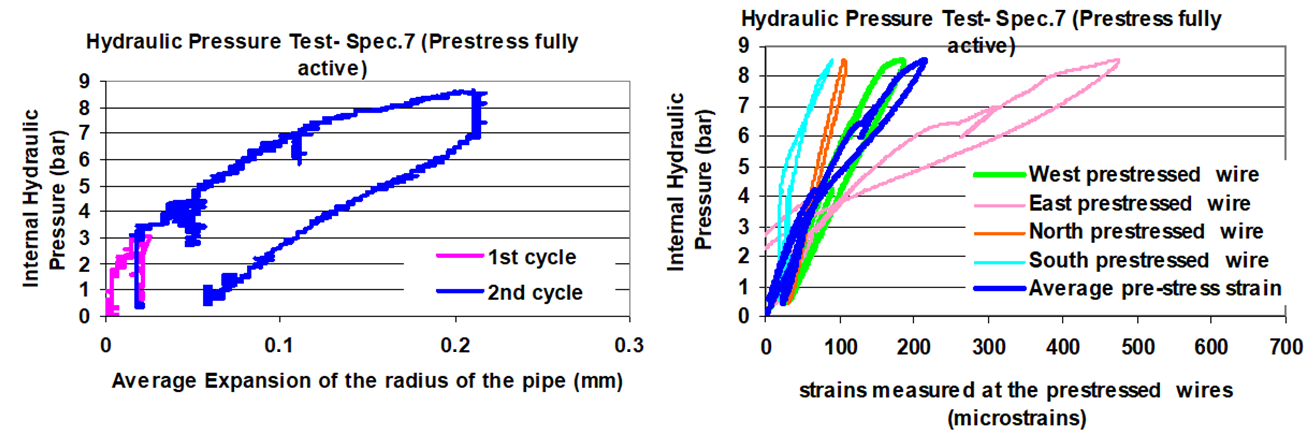
Figure 15. Measured response for Specimen 7 with fully active prestressing: ( Left ) average radial expansion of the pipe radius; ( Right ) radial strains of the prestressing wires (1 bar = 0.1 N/mm 2 ).